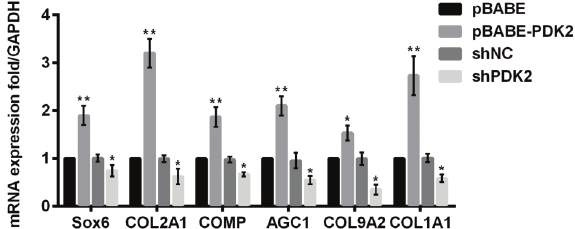
Figure 3. Effects of aberrant PDK2 on mRNA expressions of chondrogenesis markers in mesenchymal stem cell. PDK2: pyruvate dehydrogenase kinase isoform 2; sh: short hairpin; NC: negative control; Sox6: SRY-related high mobility group-box 6; COL2A1: type II procollagen gene; COMP: cartilage oligomeric matrix protein; AGC1: aggrecan; COL9A2: type IX procollagen gene; COL1A1: collagen type 1 alpha 1; GAPDH: glyceraldehyde- 3-phosphate dehydrogenase. Data are reported as means ± SD. *P o 0.05; **P o 0.01 compared with pBABE or shNC group (ANOVA).